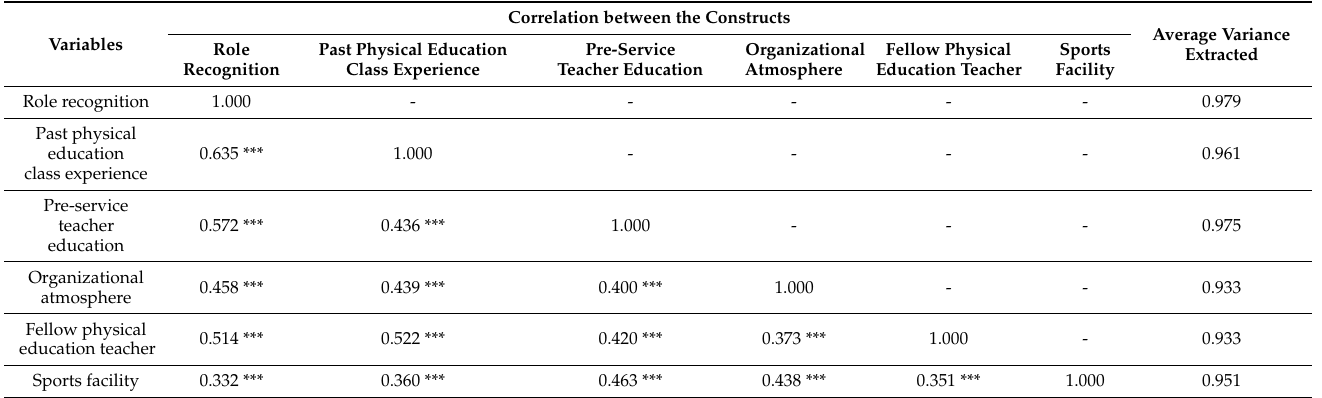
Table 5. Verification of discriminant validity.